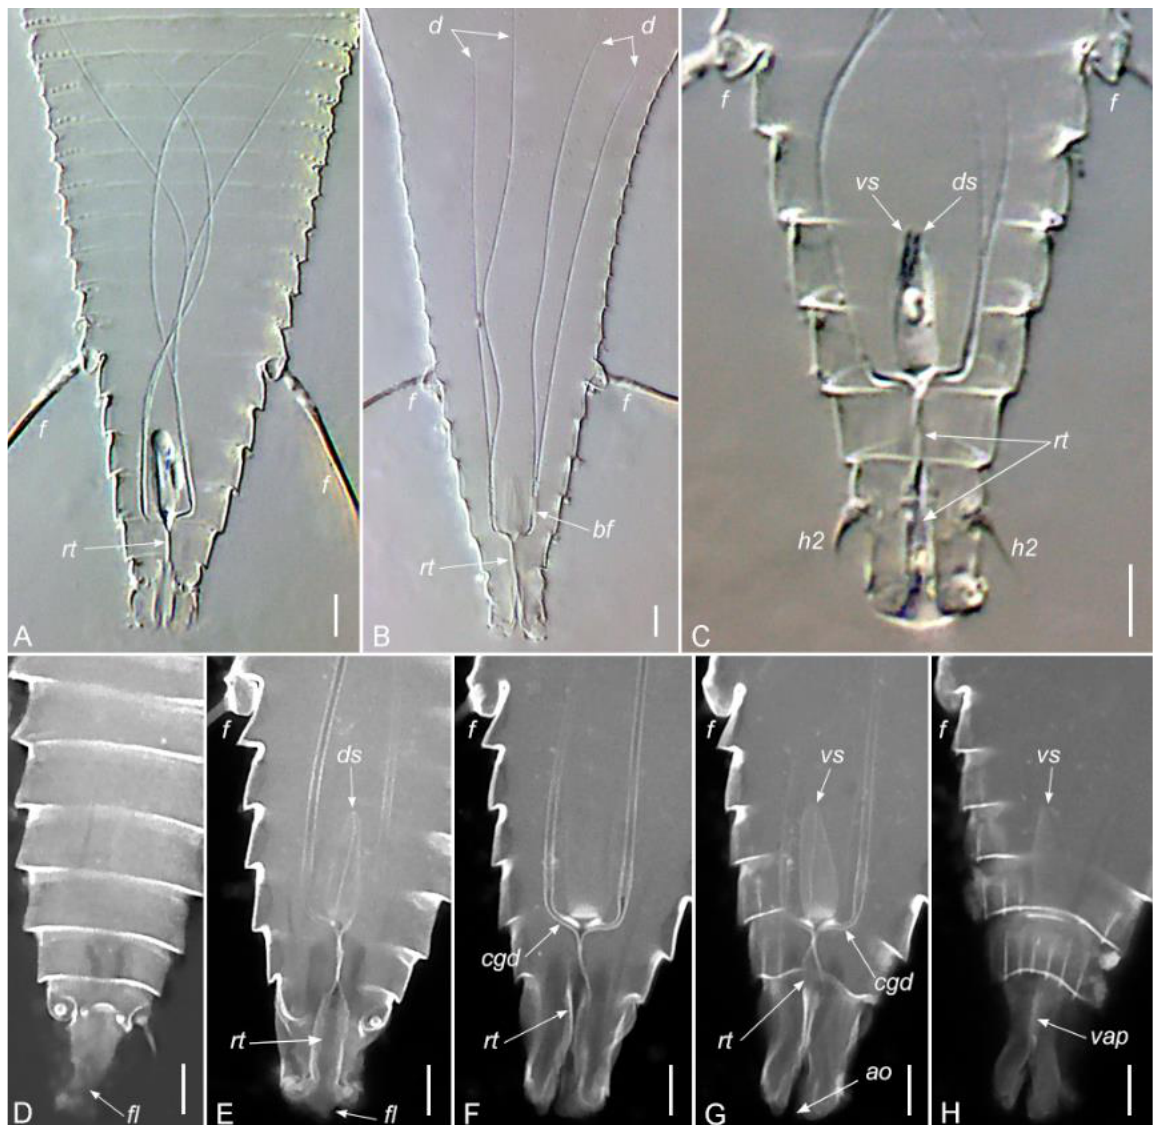
Figure 10. DIC LM ( A – C ) and CLSM images (( D – H ), microphotographs with gradually increasing depth of focus showing cuticle-lined elements of anal secretory apparatus in Aberoptus schotiae n. sp. Scale bar = 2 µm. Notations: ao — anal opening, bf — bifurcation of common gland duct, d — gland duct , cgd — common gland duct, f — seta f , fl — flap, h2 — seta h2 , ds — dorsal sac, vs — ventral sac, rt — rectal tube, vap — ventral apodeme.